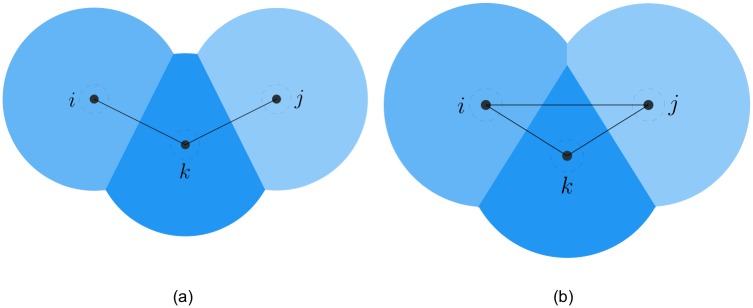
The second switching case.The case of creating one link at the switching time. (a) before switching. (b) after switching.